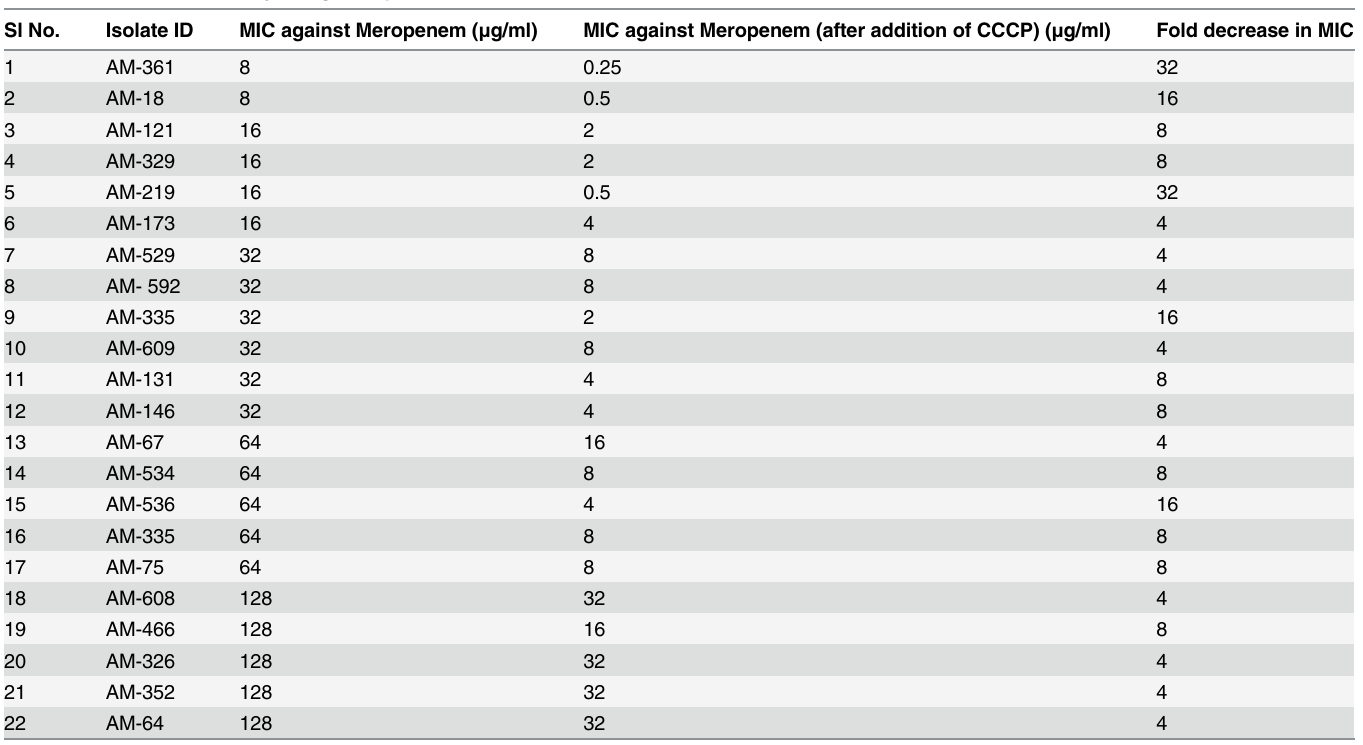
Table 2. MIC reduction assay using meropenem.